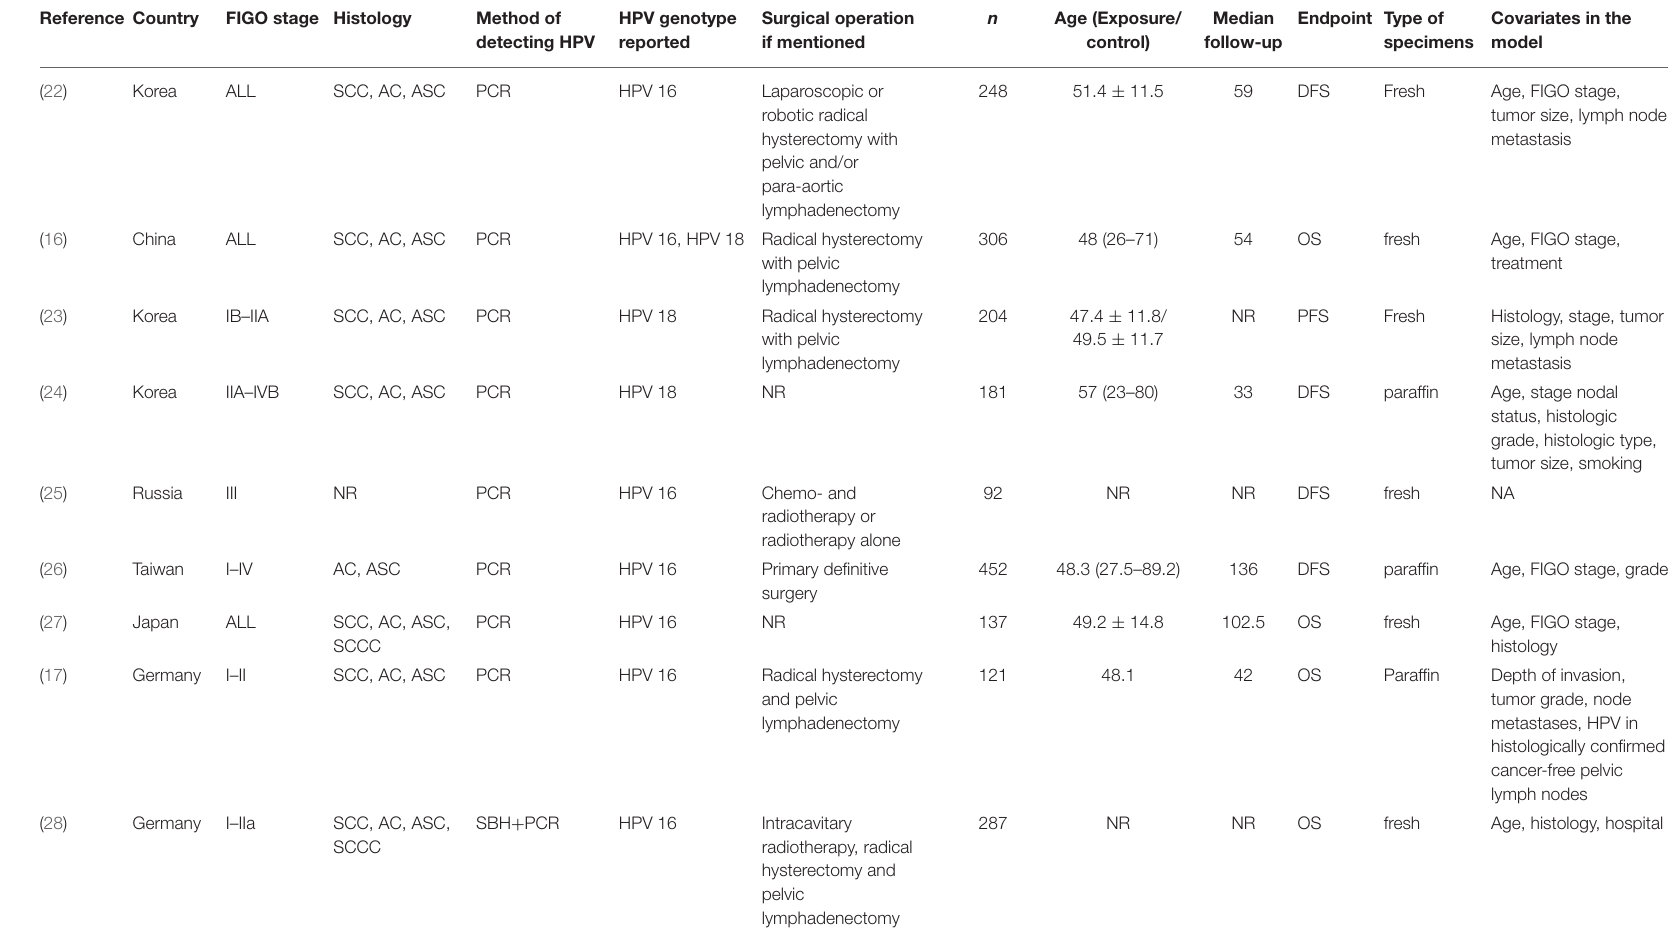
TABLE 1 | Literature search and study characteristic. Reference Country FIGO stage